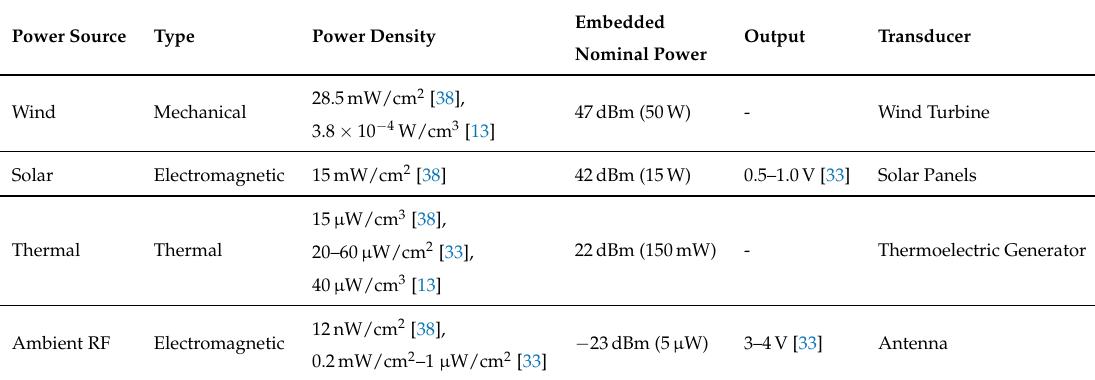
Table 1. Comparison of energy harvesting sources [38]. RF: radio